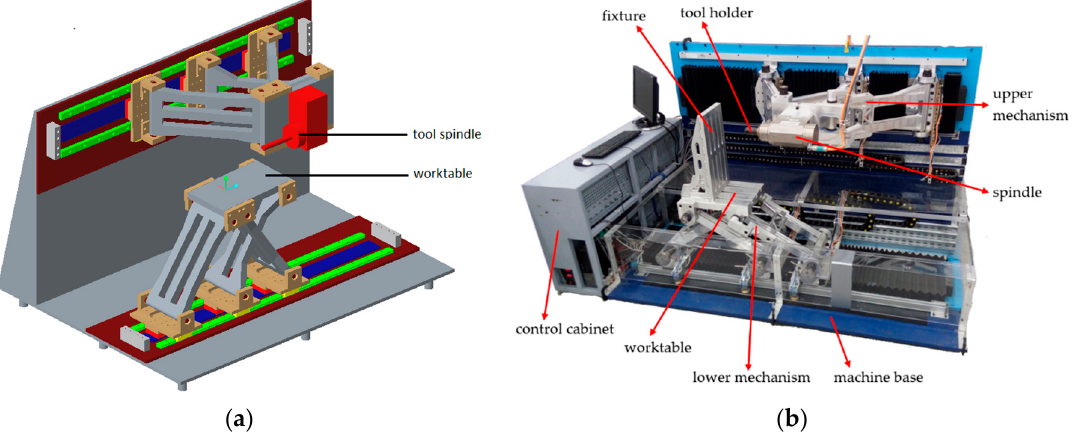
Figure 3. The ( a ) schematic and ( b ) prototype of the hybrid five-axis machine developed by conjugating two nonsymmetric planar 3PRR PMs.